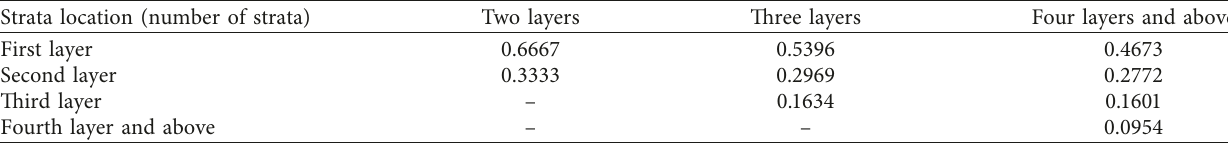
Table 6: Rock layer strength contribution rate w